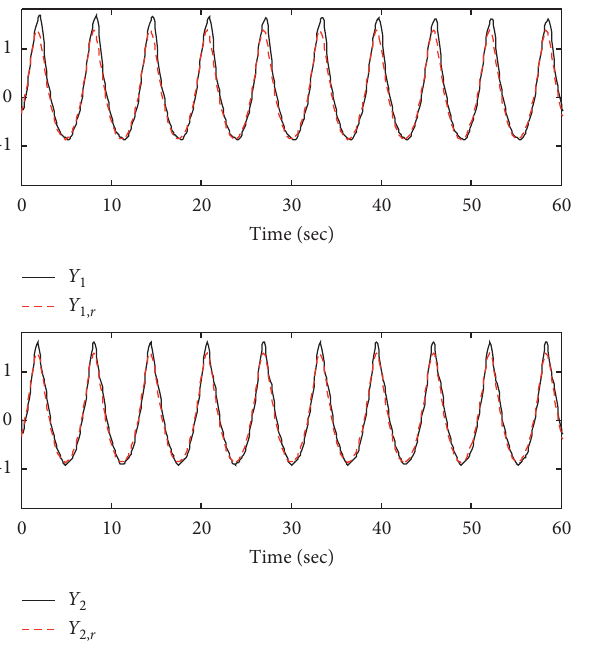
Y Figure 3: Trajectories of control inputs u ∗ i,r .